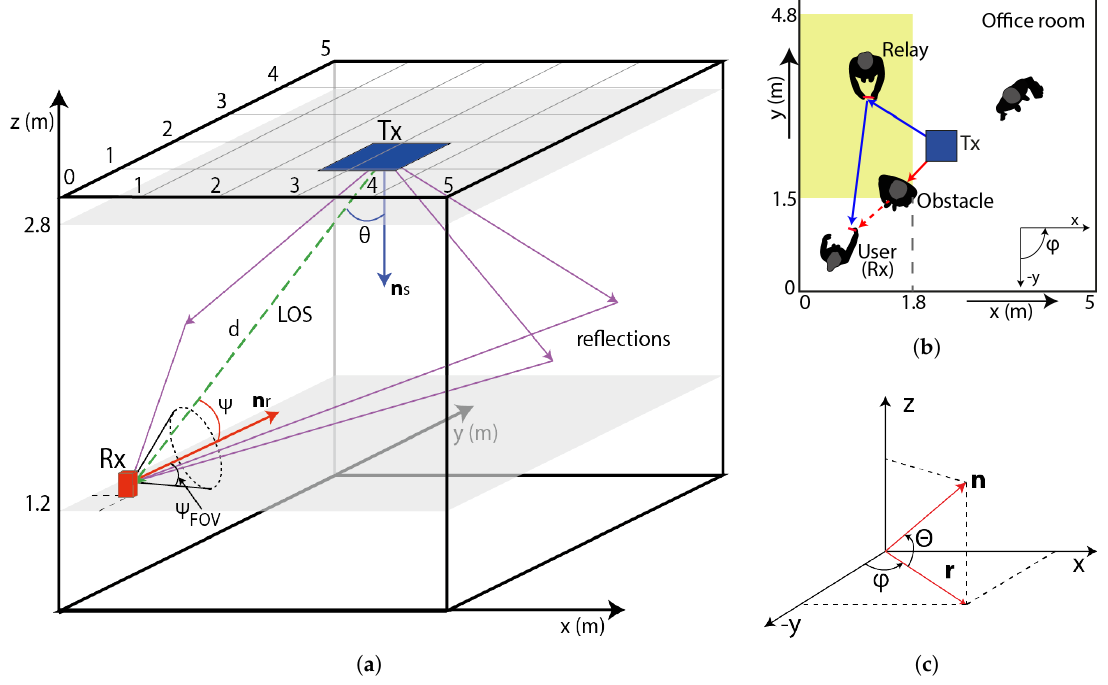
Figure 1. Room model: ( a ) Tx and Rx geometry model; ( b ) users’ situation in the room; and ( c ) the coordinate